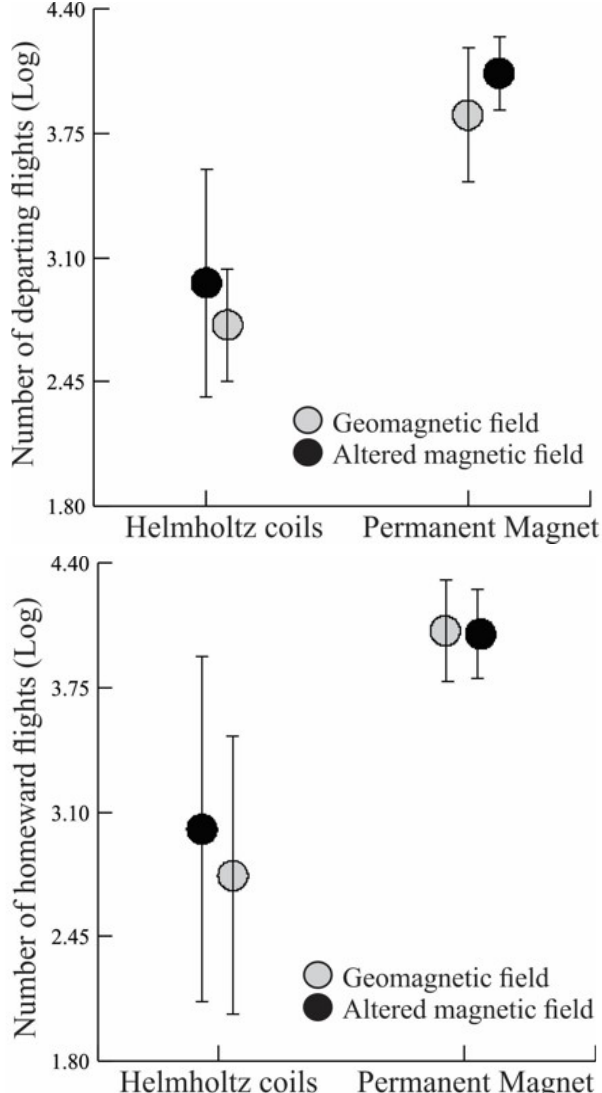
Fig 2 . Mann-Whitney test of the number of departing flights and number of homeward flights performed by workers of the colonies of Polybia paulista , during the experiments with the Helmholtz coils (geomagnetic field H=6,00; p=0,014 and altered magnetic field H=6,06; p=0,014) and permanent magnet (geomagnetic field H=6,00; p=0,014 and altered magnetic field H=6,21;